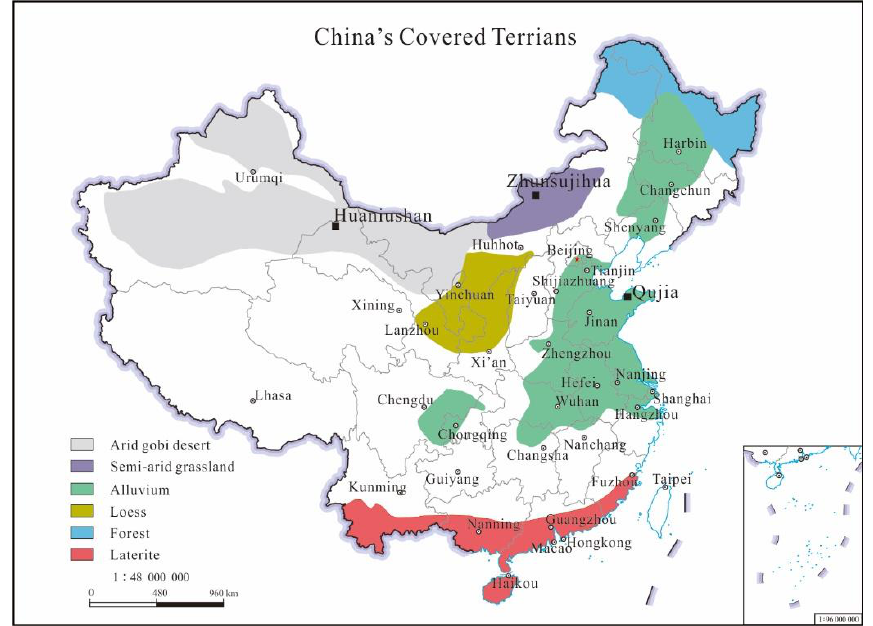
Figure 1. China’s covered terrains (modified after Wang et al. [2]) and location of the deposit